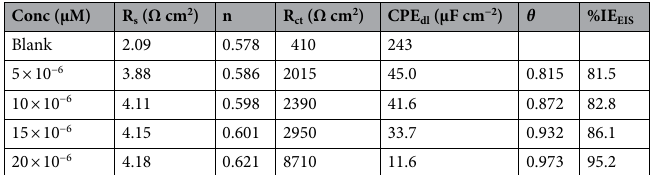
Table 3. EIS kinetic parameters for DTG